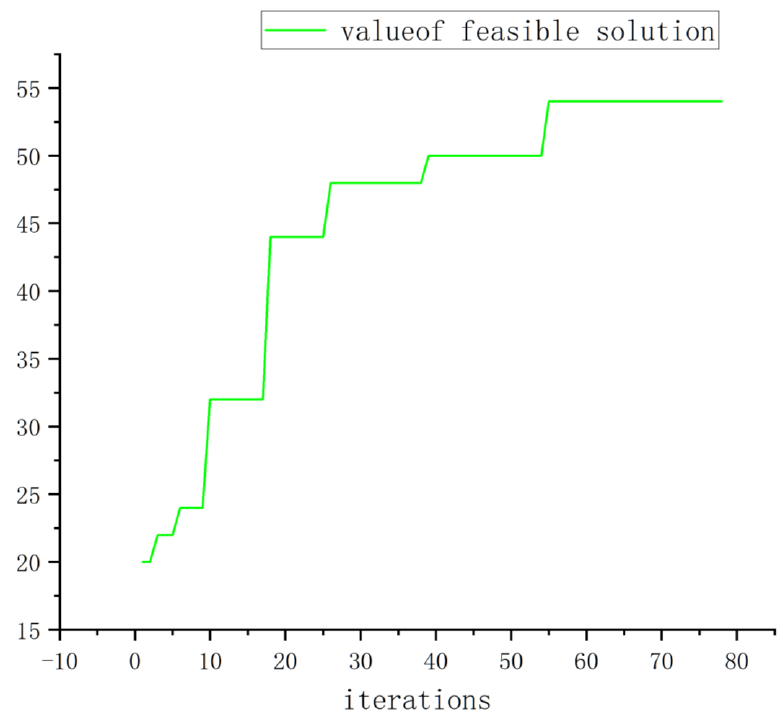
Figure 10. The value of the original objective. Table 6. CPU time of